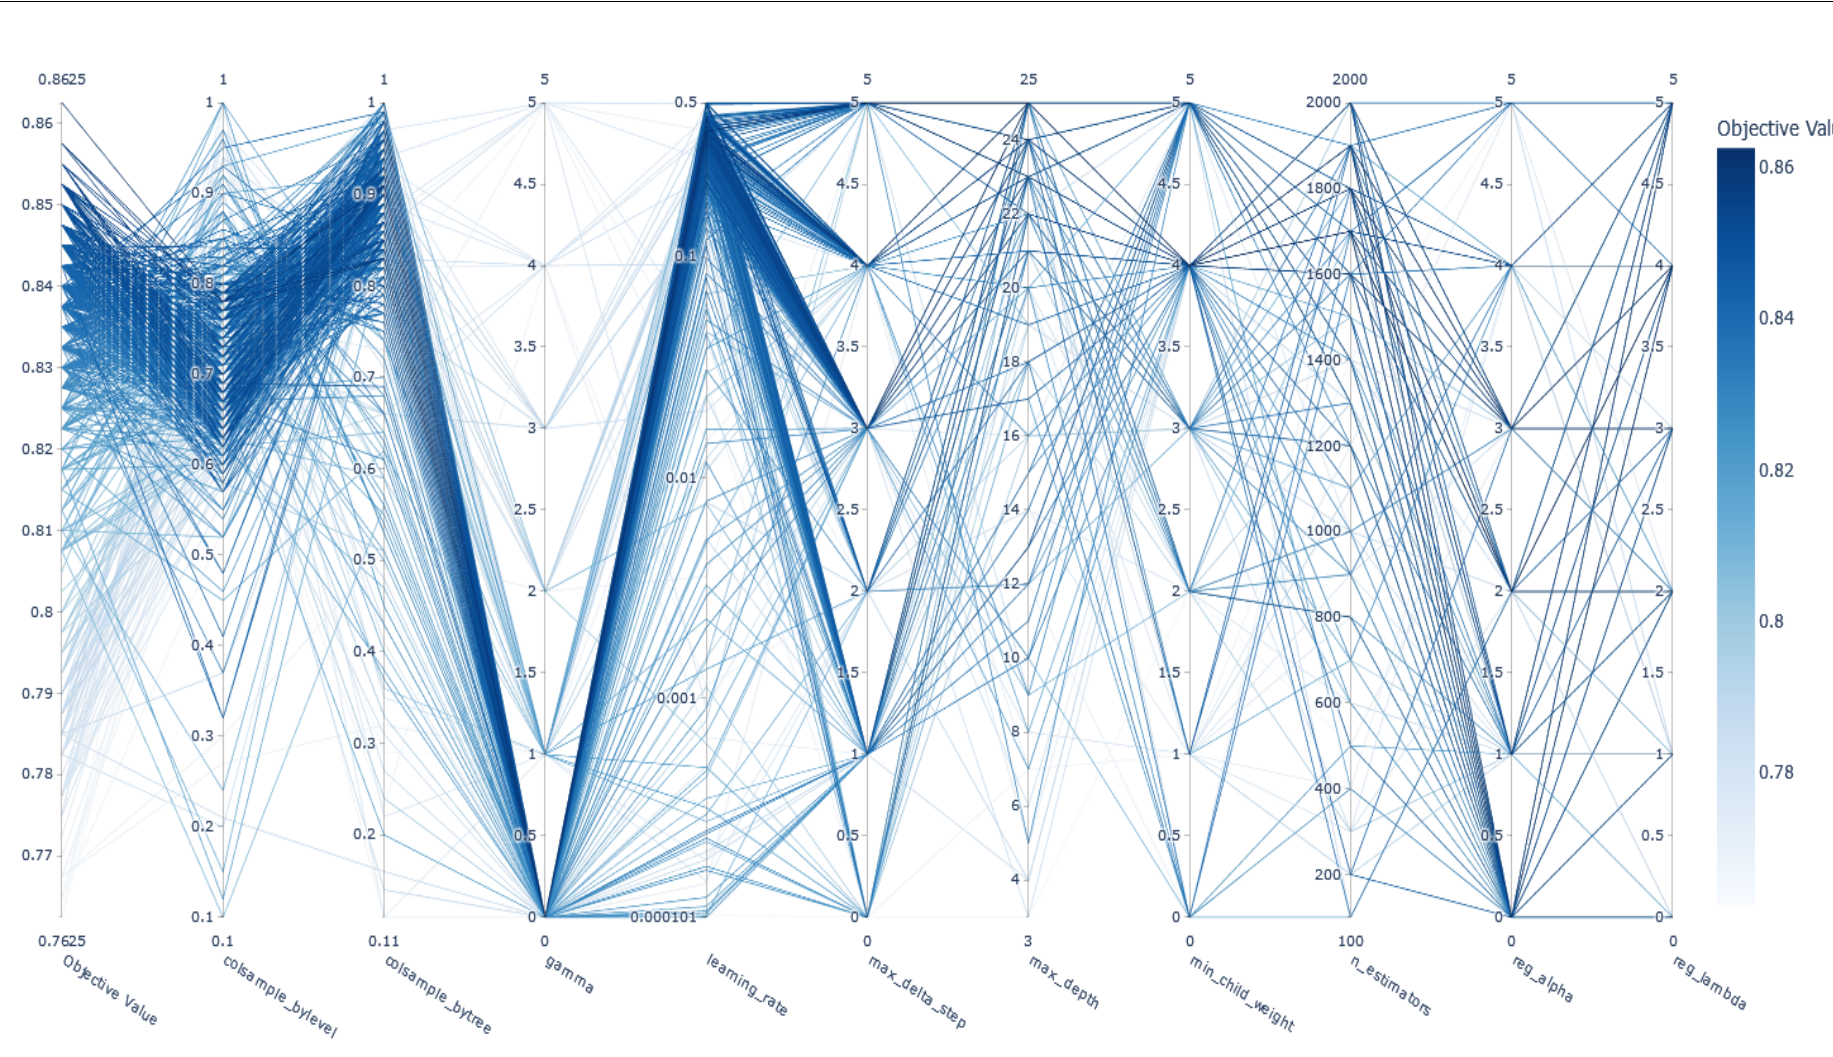
Figure 6. Hyperparameters’ parallel coordination view for the XGboost